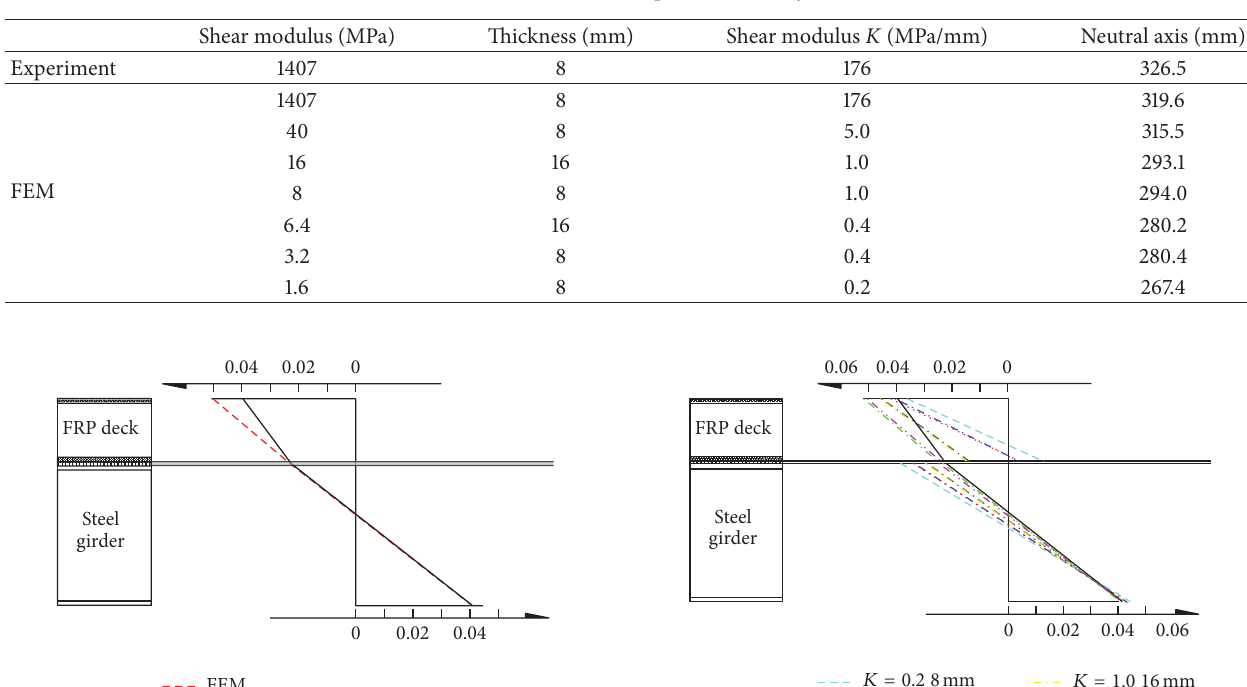
Table 3: Results of the parametric study.